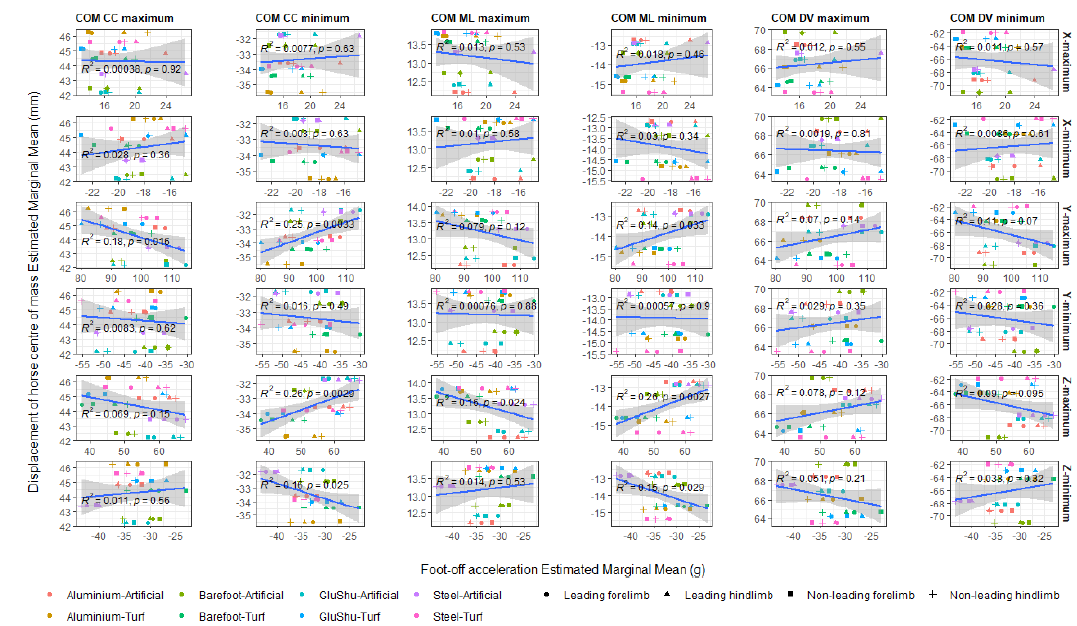
Figure A8. Relationship between foot-off acceleration data and centre of mass (COM) displacements. Data are subdivided horizontally by the hoof acceleration parameters (x-maximum, x-minimum, y-maximum, y-minimum, z-maximum and z-minimum) and vertically by the COM parameters (CC-maximum, CC-minimum, ML-maximum, ML-minimum, DV-maximum and DV-minimum), as indicated by the labels on the right and top sides of this figure. Within each subplot, the data are further subdivided according to both shoe–surface combination and